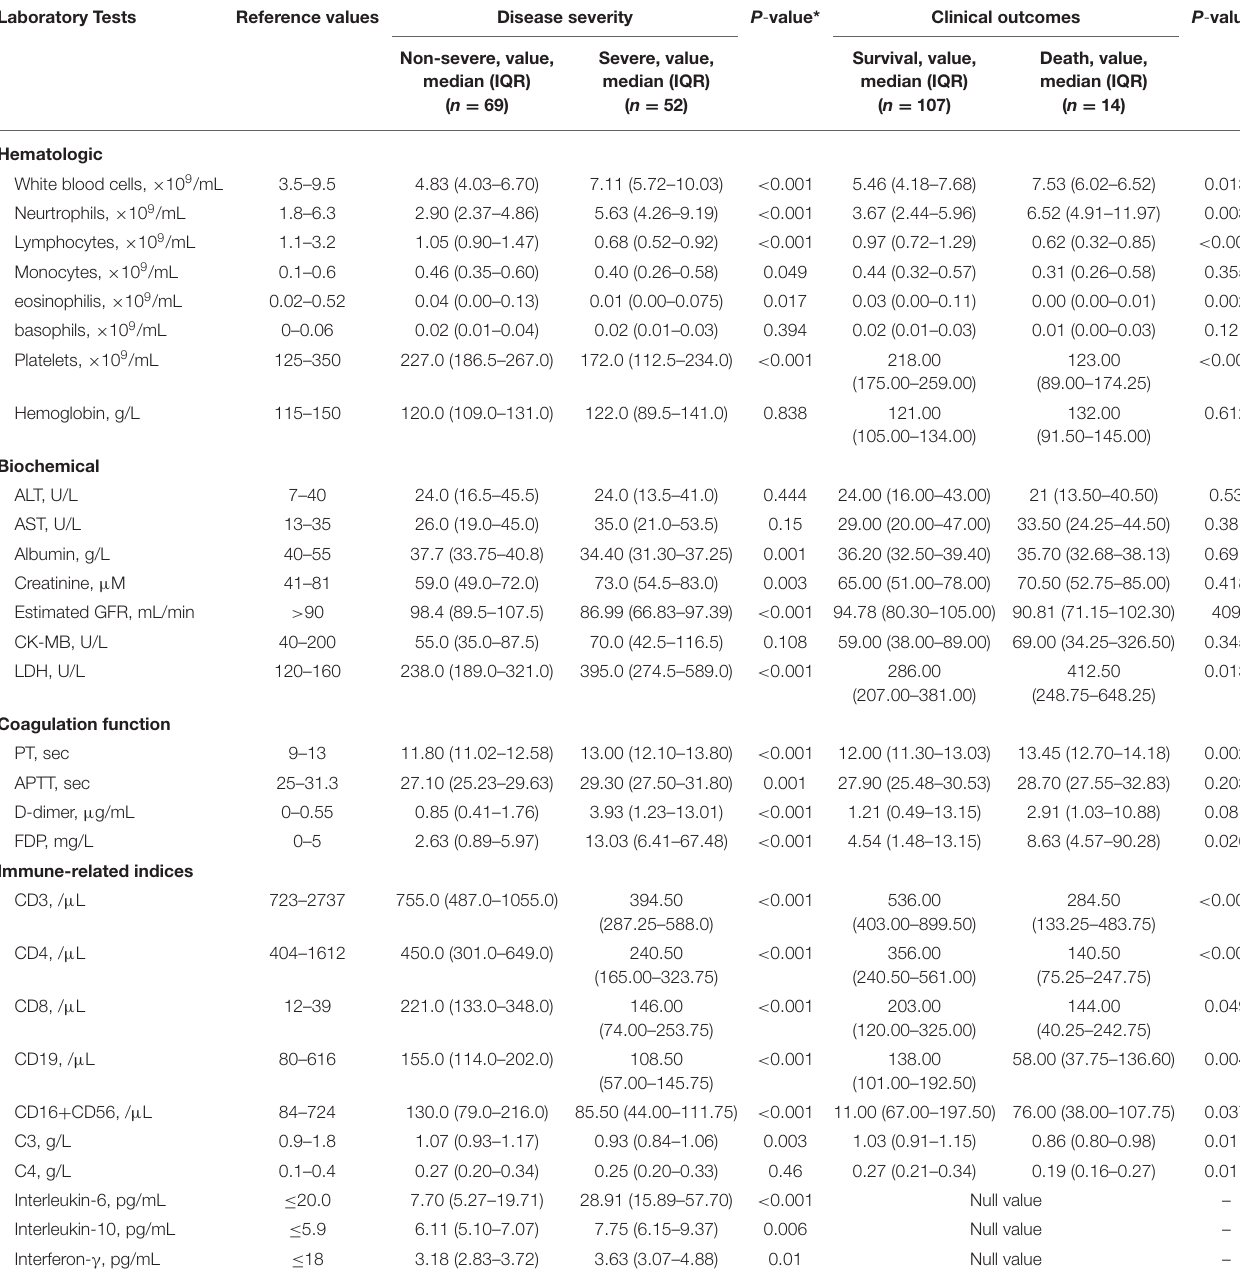
TABLE 3 | Initial laboratory indices of different disease severity and clinical